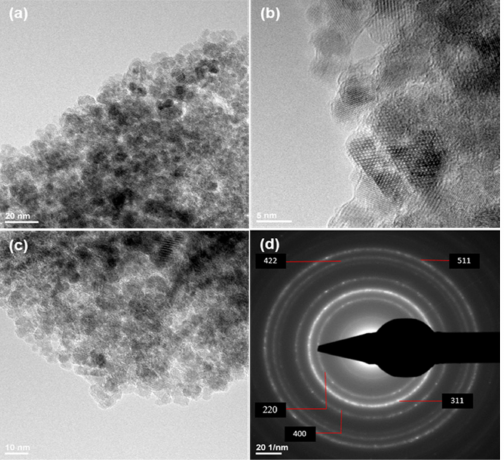
Figure 3. TEM ( a – c ) micrographs and SAED pattern ( d ) of Fe 3 O 4 @ β -CD nanopowders. The simultaneous enthalpy and mass changes vs. temperature curves